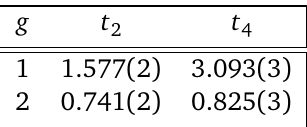
Table 2: The results obtained for closed chain model with four matrices with g = 1,2 and N = 300 at fixed c = κ =